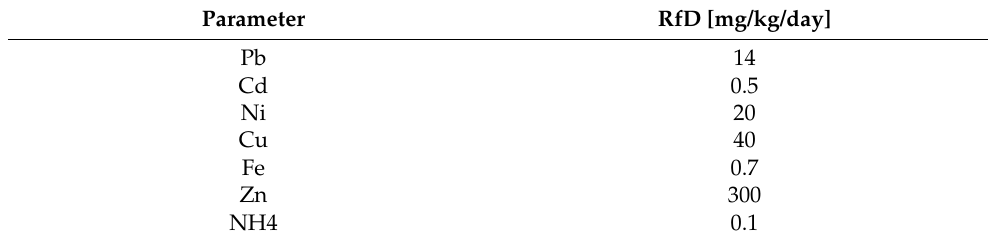
Table 2. RfD values for analyzed parameters